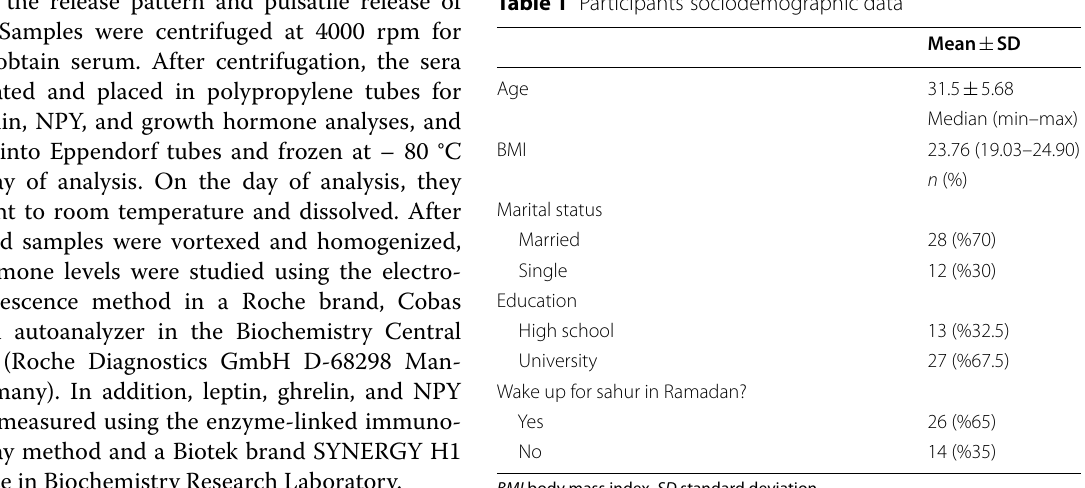
Table 1 Participants’ sociodemographic